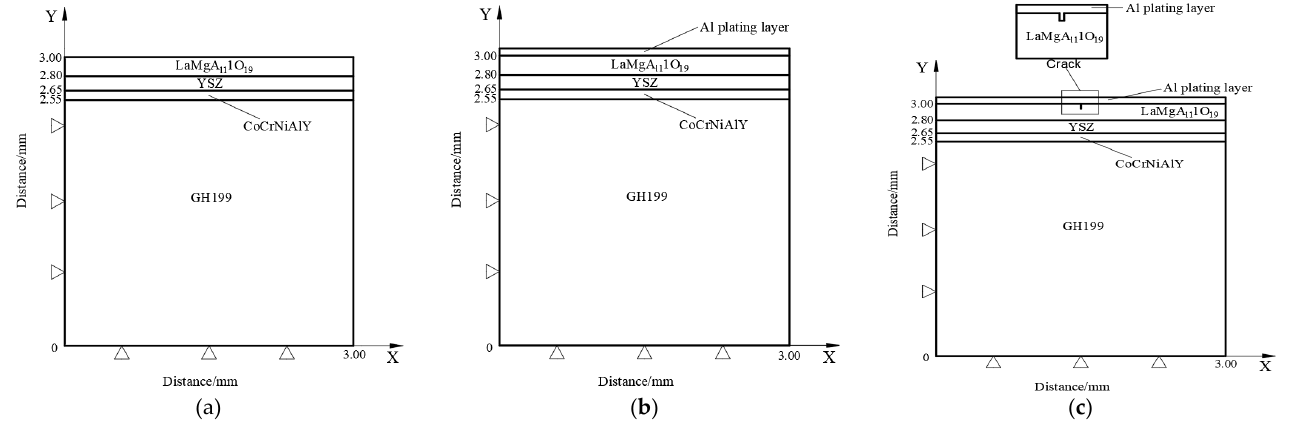
Figure 1. Three-dimensional finite element physical model: ( a ) M1, ( b ) M2.